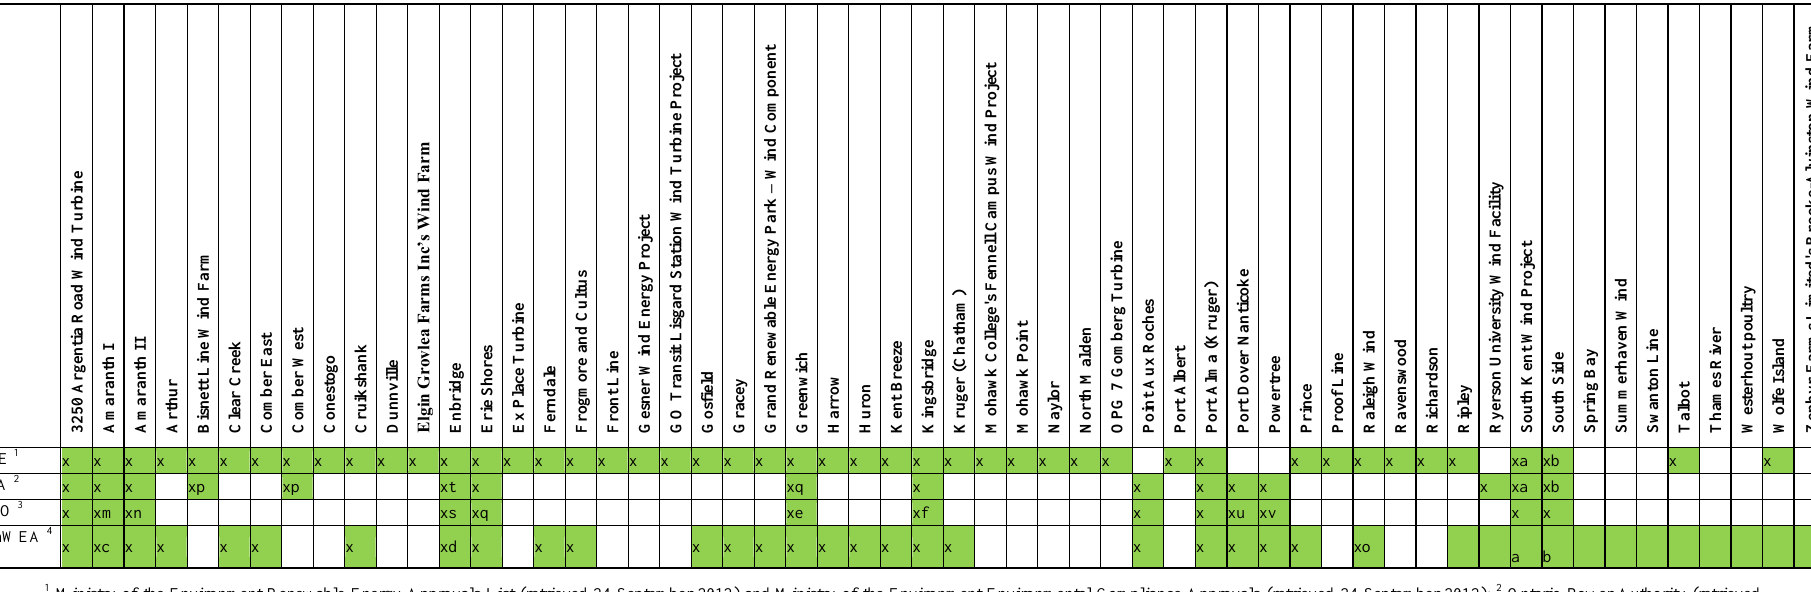
Table 1. Comparison of project lists by